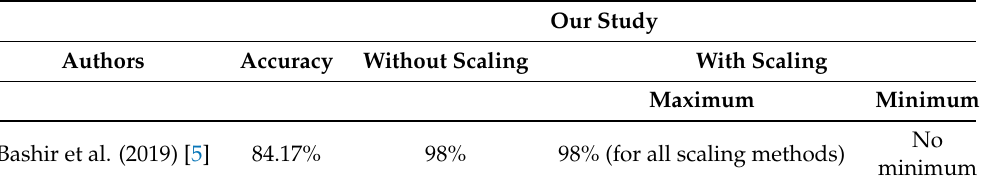
Table 13. Comparison with previous study—RF.